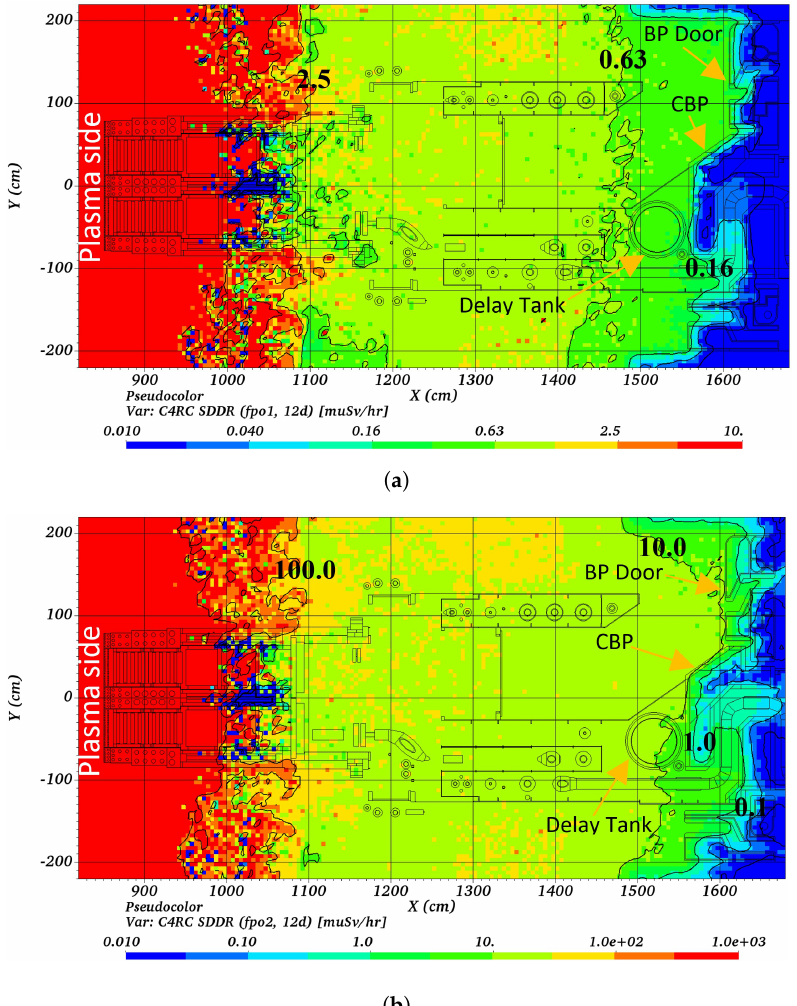
Figure 16. SDDR [ µ Sv/h] for the baseline configuration (C4RC) at 12days following ( a ) FPO1 and ( b ) FPO2